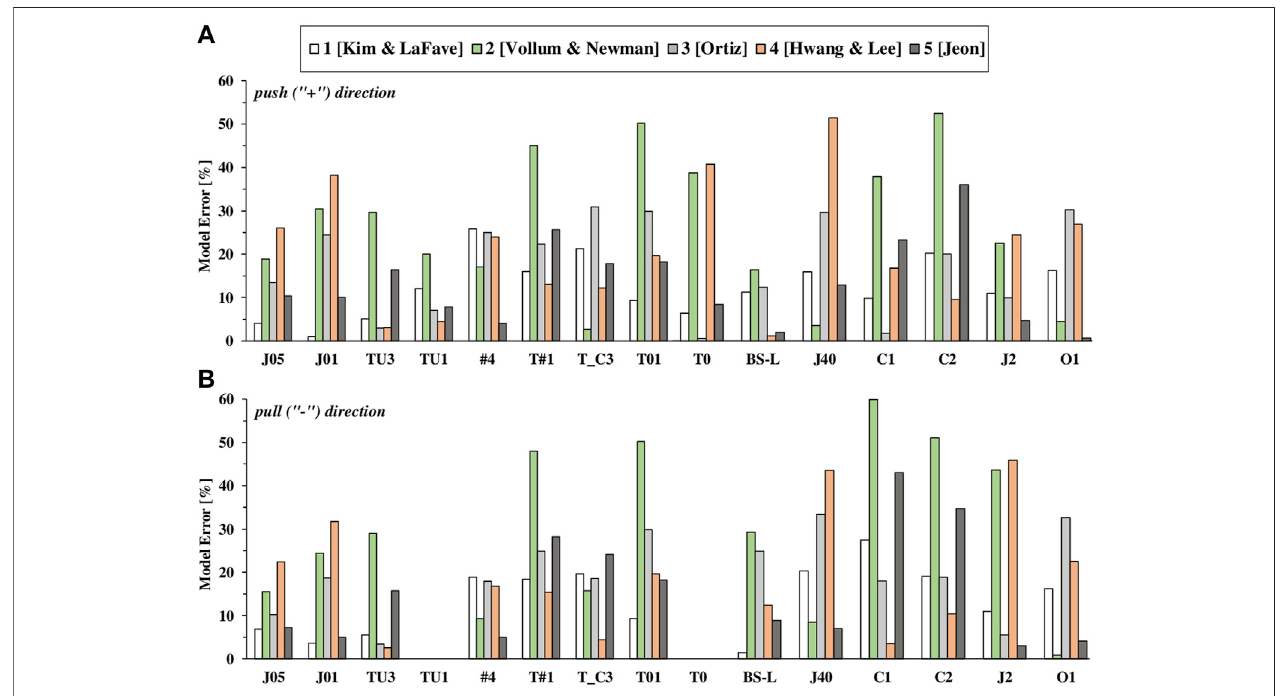
FIGURE 3 | Model errors in terms of τ max for each considered experimental test: push direction (A) ; pull direction (B) .